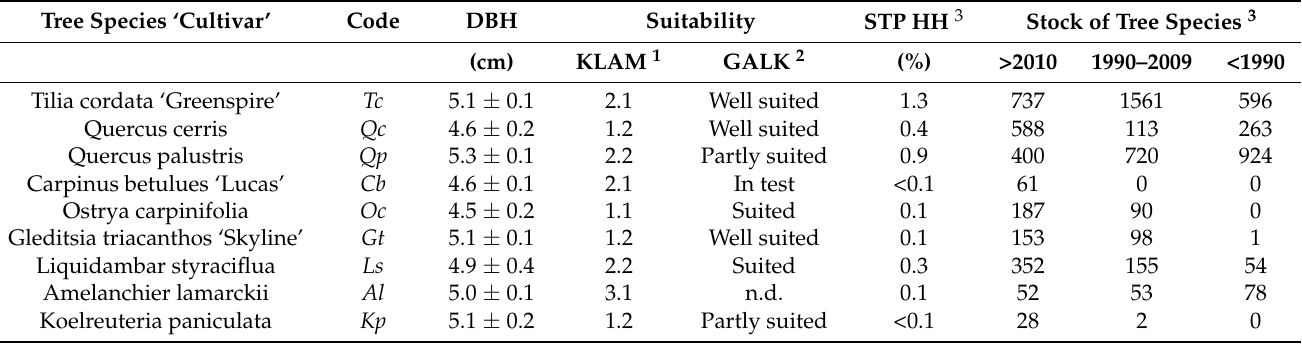
Table 1. Tree species characteristics. Planting diameter at breast height (DBH in May 2019) and suitability classifications of the investigated tree species for use as street trees. STP HH is the actual percentage of the investigated tree species from Hamburg’s total street tree population (state: 31 December 2020). Stock of tree species is listed according to age class: The tree species were determined via the Hamburg tree cadaster and show the street tree population according to age classes classified by planting year after 2010, between 1990 and 2010, and before